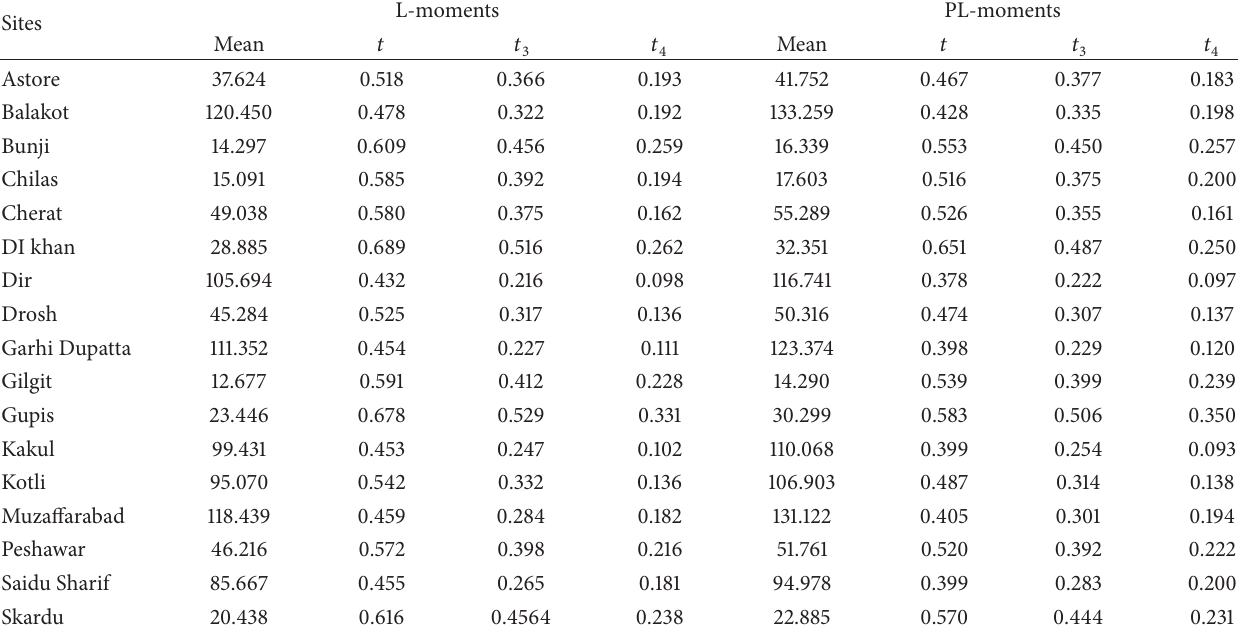
Table 1: Statistics of annual extreme monthly precipitation for study region based on L-moments and PL-moments. Sites